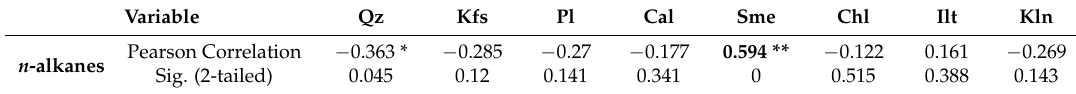
Table 8. Correlation matrix of the total content in n -alkanes ( µ g/g) and mineral content of the samples.